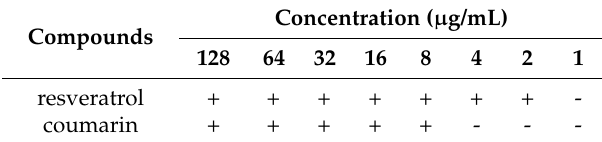
Table 2. Effects of different compounds on the growth of R. solanacearum after 24 h incubation.